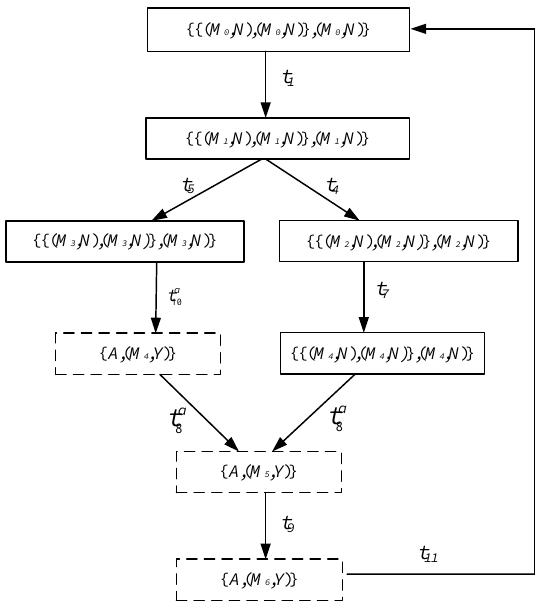
Figure 14. The combined basis verifier G T